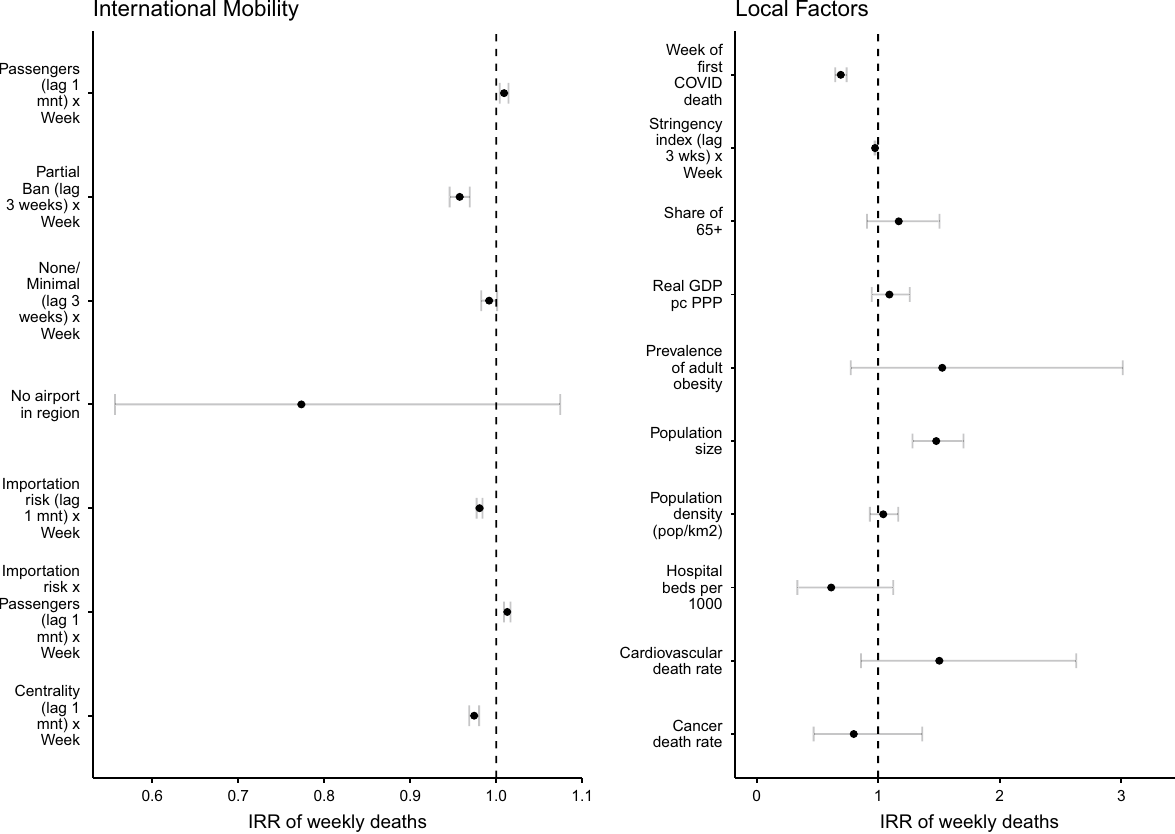
Figure 2. The impact of air passenger traffic on the severity of COVID-19 deaths (number of deaths per week) in April–October 2020, controlling for population mixing (NPI), structural predispositions and recursive effects. Generalized linear mixed-effects models. Risk ratios and confidence intervals. For full model specification with coefficients, see Table C1 in Supplementary Information. Source : Sub-National COVID-19 Incidence and Determinants